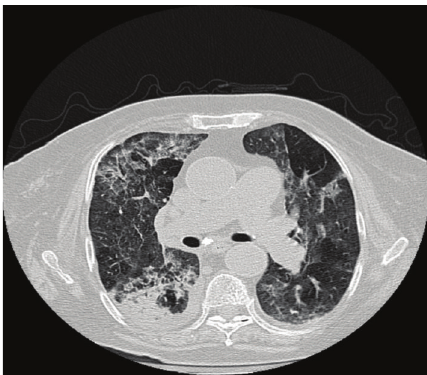
Figure 1: Patient’s high resolution chest computed tomography demonstrating distortion of the pulmonary architecture with thick- ening of pulmonary interstitium and areas of ground-glass mor- phology, enlargement of pulmonary arteries, and right lower lobe opacities.